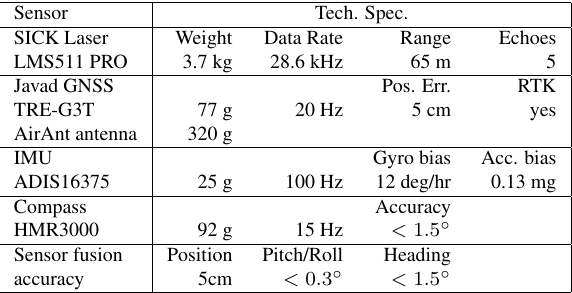
Table 1: Airborne LiDAR system sensor